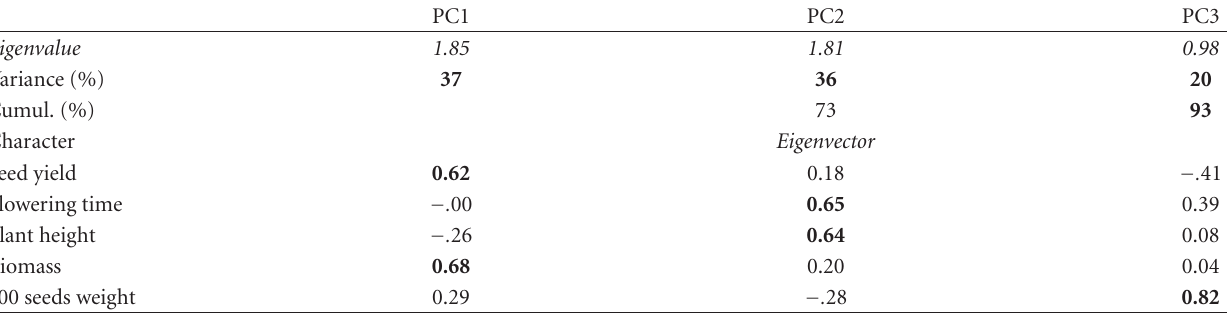
Table 3: Principal component analysis: eigenvalues, eigenvectors, and percent of variation accounted for the first three principal components (PCs).